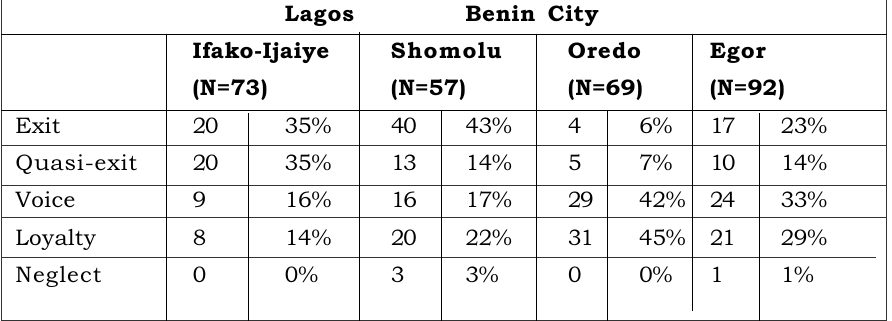
Table 5. Responses to water problems by local